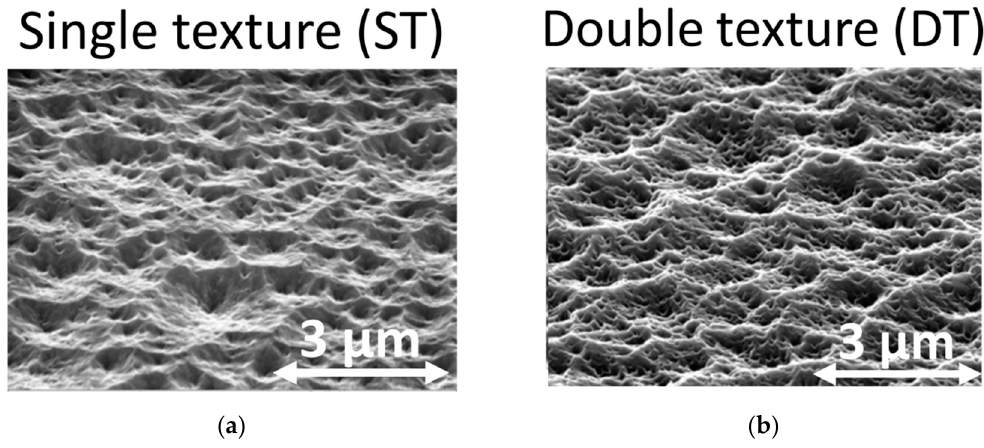
Figure 7. SEM surface images of single-textured (ST) and double-textured (DT) surfaces: single-textured after HCl etch only ( a ), double-textured with HCl etch + subsequent HF-dip ( b ).